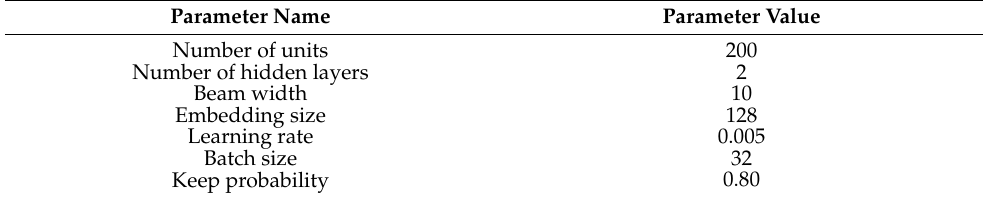
Figure 3. Sensitivity analysis results for number of units on the testing dataset. Table 9. Experimental parameters for number of epochs sensitivity